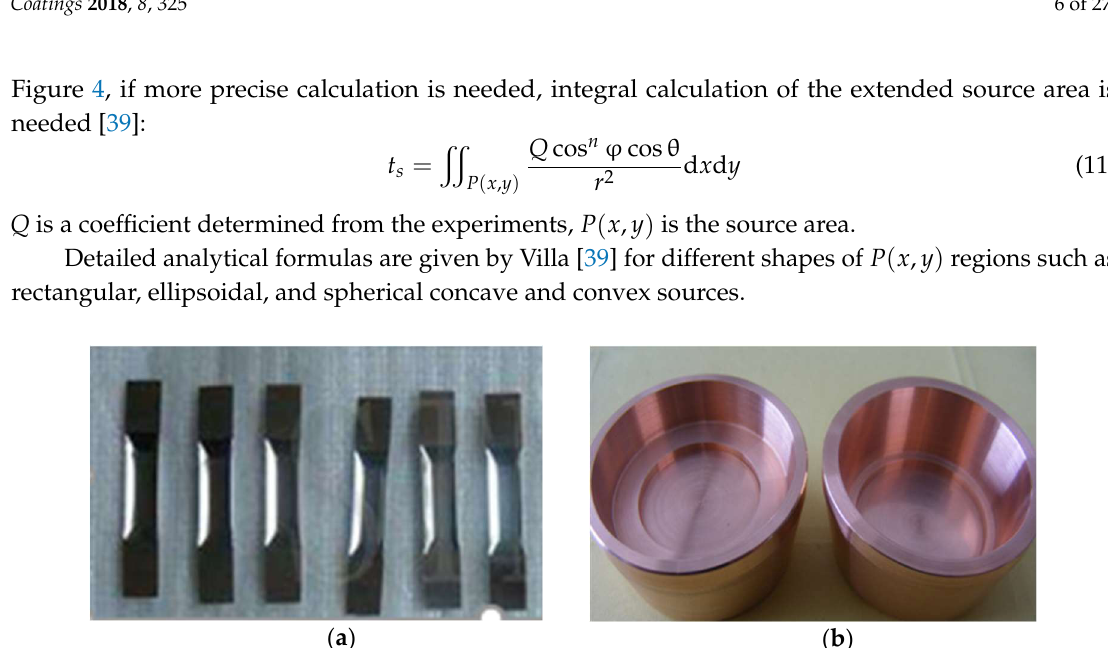
Figure 4. ( a ) Molybdenum boats for thermal evaporation; ( b ) crucible for electron-beam (EB) evaporation.